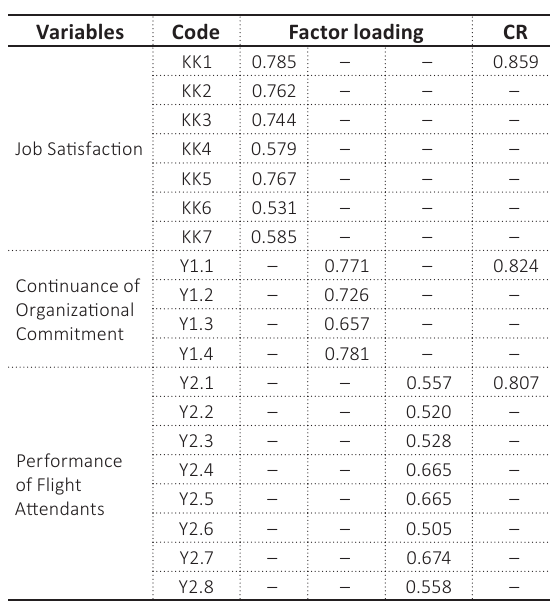
Table 2. Validity and reliability test